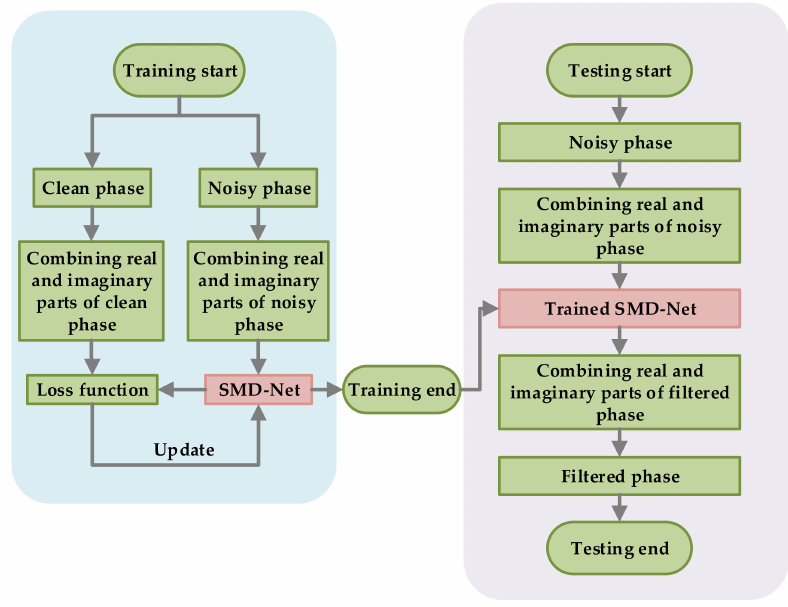
Figure 1. The flow chart of the interferometric phase filtering via the